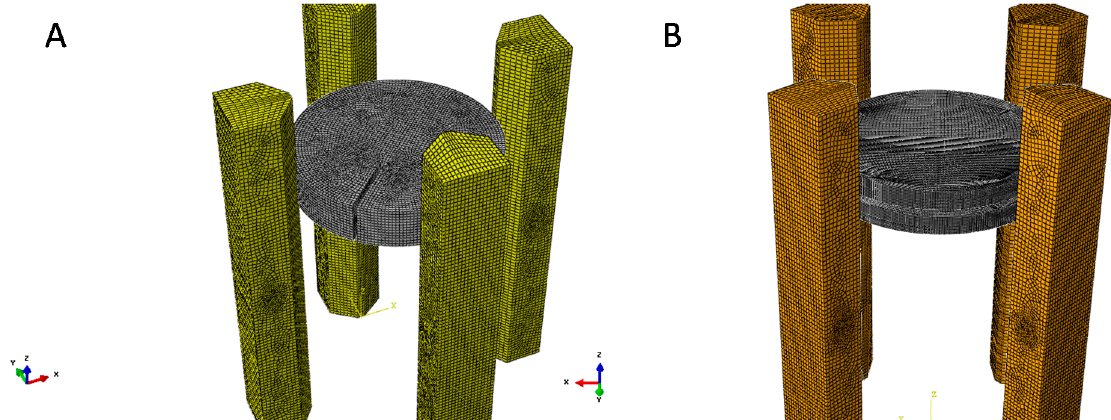
Figure 11. Mesh model used for FEM and VdP methods; ( A ) radial crack, placed between the probes; ( B ) transverse cracks.